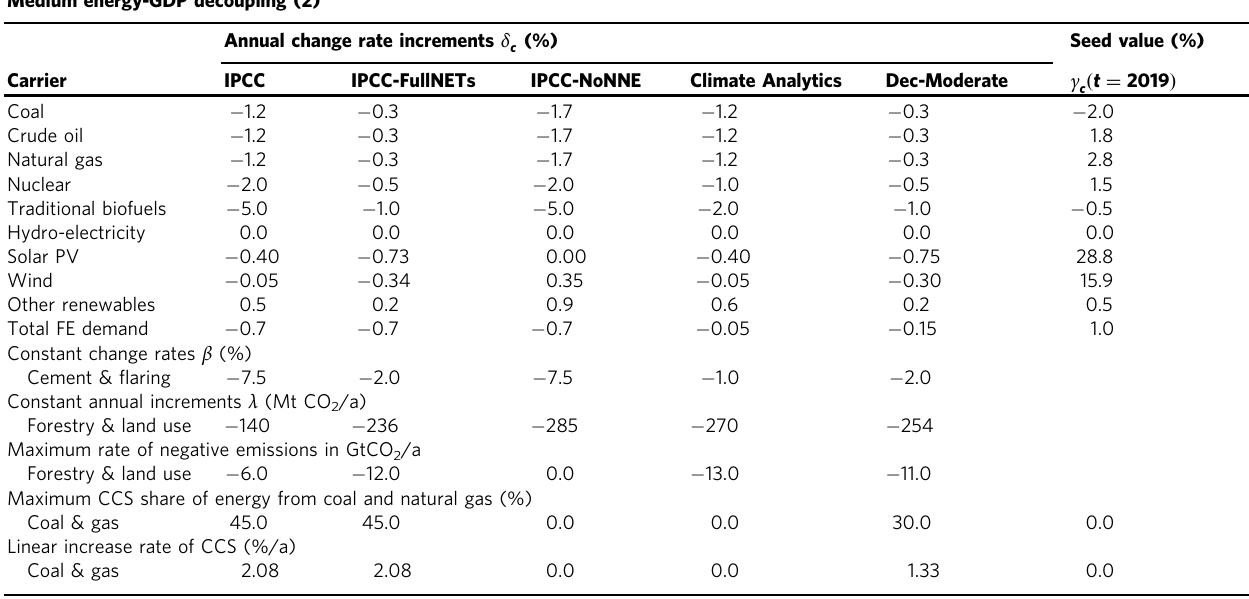
Table 5 Parameters for pathways with medium energy-GDP decoupling (2).